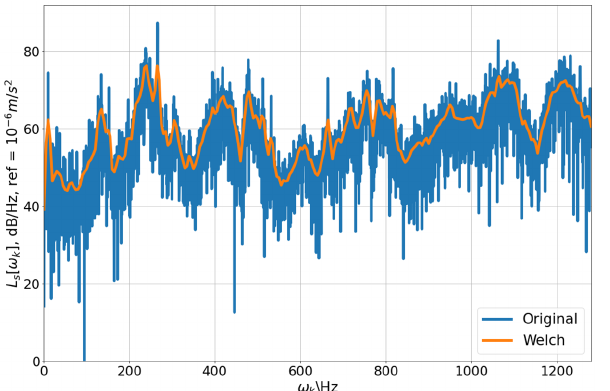
Figure 4. Power spectral density periodogram level from reactor top axial sensor ( s = 1) on a certain day. Reference at 10 − 6 m/s 2